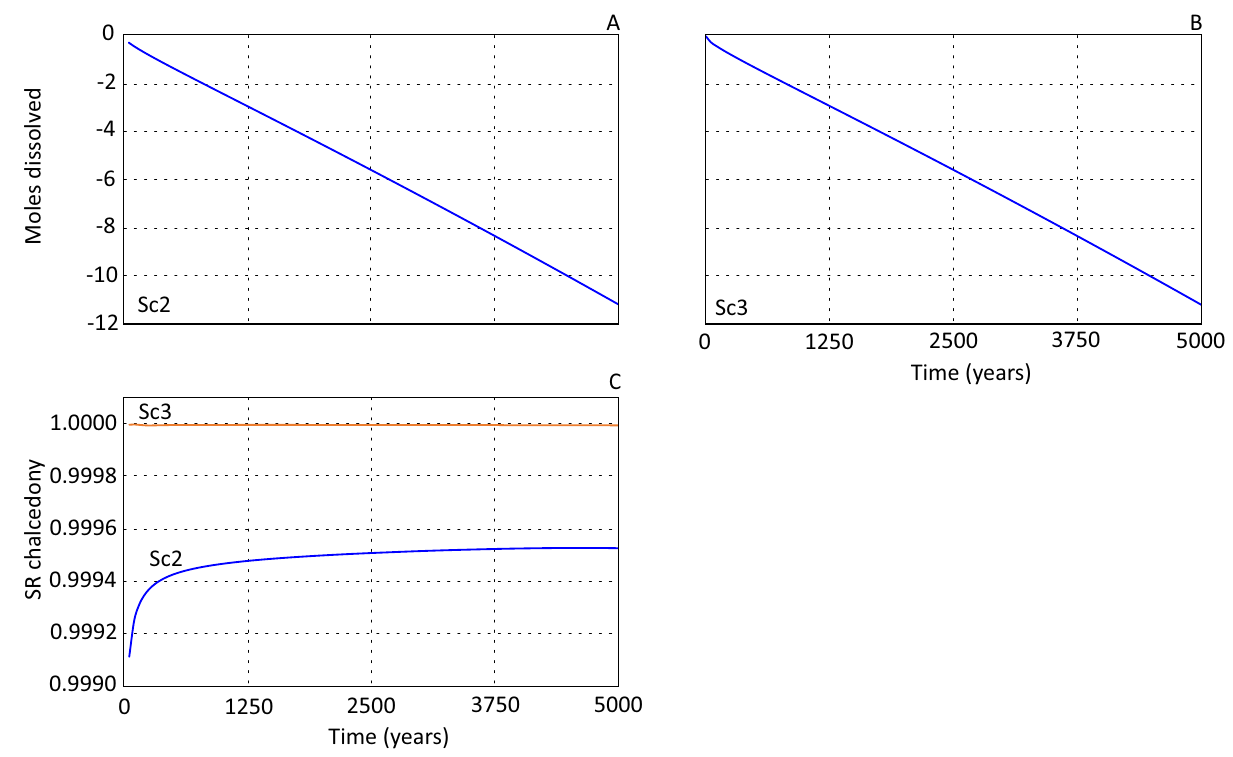
Figure 4. Basalt dissolution displayed for cell #1 (Fig. 2) as change in moles as a function of simulated time for scenario 2 ( A ) and 3 ( B ) where scenario 3 was simulated with a reactive surface area two orders larger than scenario 2. ( C ) shows saturation ratio (SR) for chalcedony in cell #1 for scenario 2 and 3 over the simulated